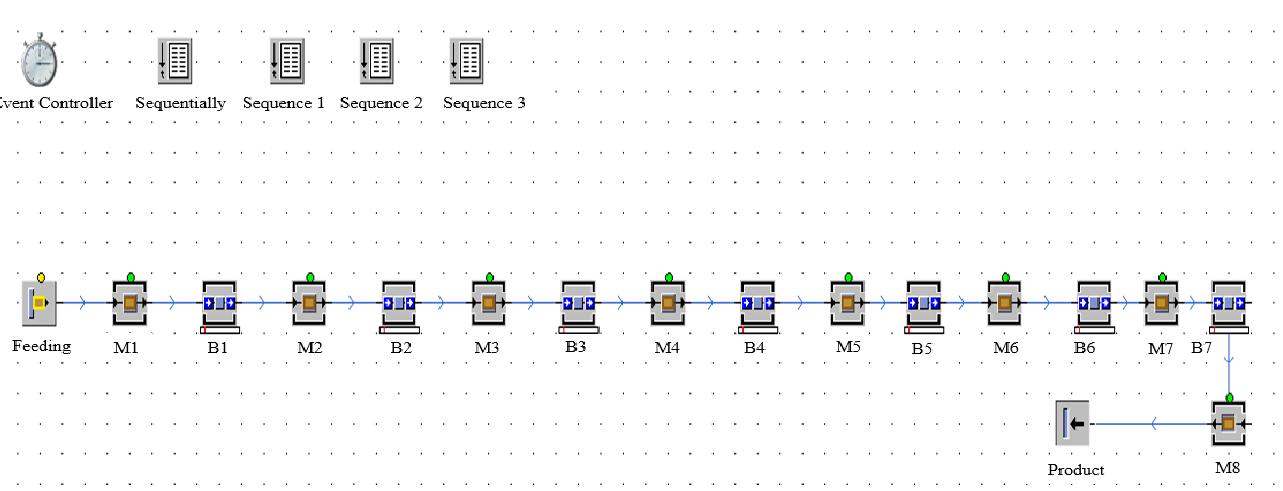
Table 2. Terminal time delay quantization results.